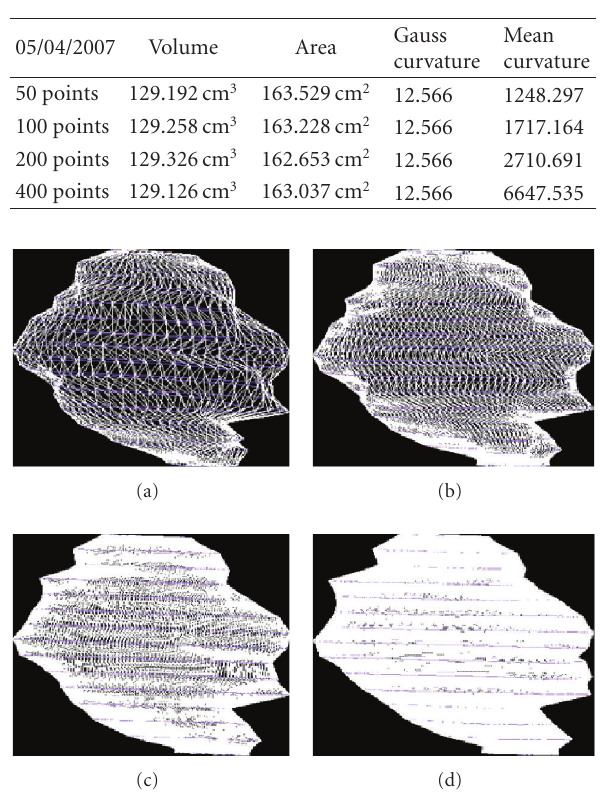
Figure 21: Patient 1. (a) 50 points on the contours, (b) 100 points on the contours, (c) 200 points on the contours, and (d) 400 points on the contours.